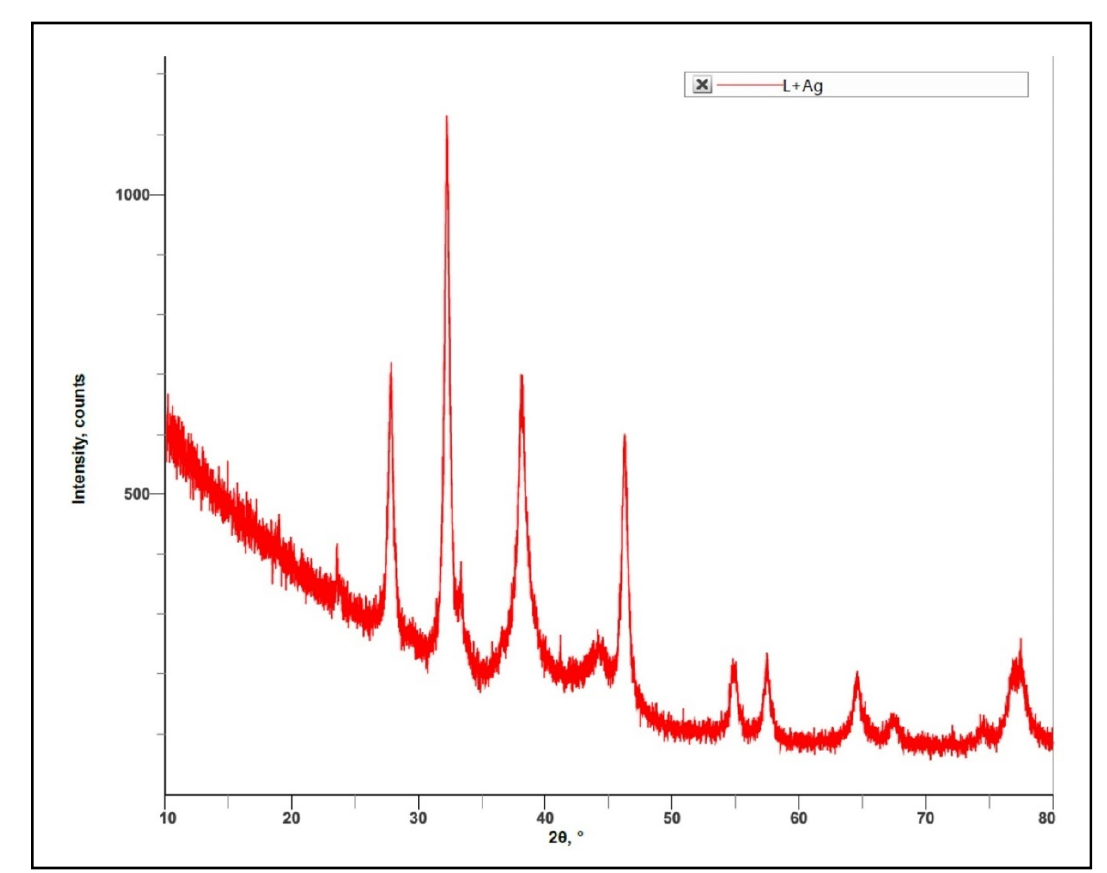
Figure 9. XRD analysis of R. apiculata AgNPs confirming its crystalline nature. Table 2. FRAP assay of aqueous leaf extract of R. apiculata and its synthesized